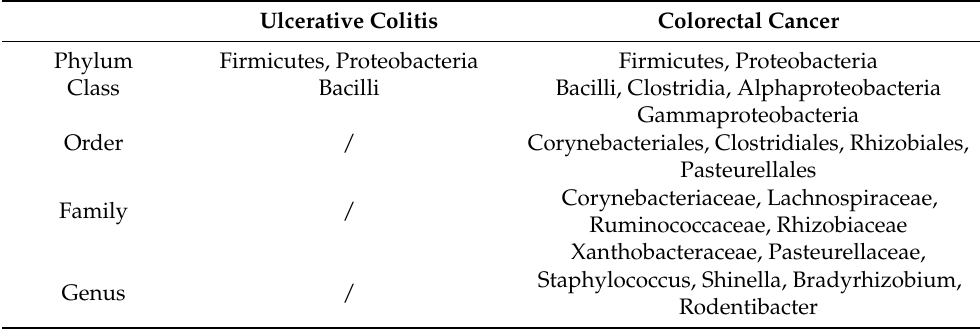
Table 2. Different pulmonary microorganisms between the ulcerative colitis (UC) group and the colorectal cancer (CRC) group at the levels of the phylum, class, order, family, and